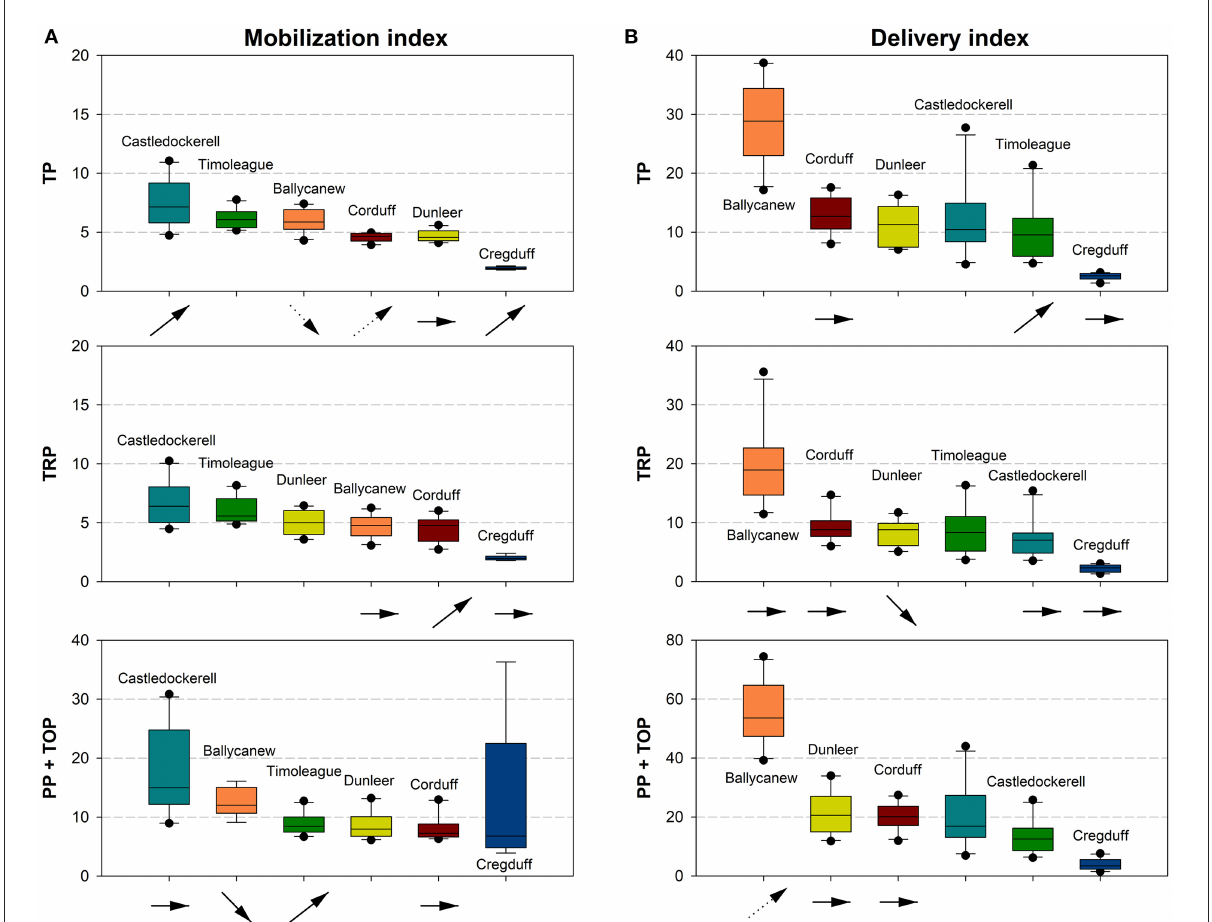
FIGURE5 (A) Mobilization indices and (B) Delivery indices of TP, TRP, and PP + TOP in six agricultural catchments. The indices are based on sub-hourly averages of P concentrations and mass loads for ten hydrological years (1st Oct 2010 to 30th Sep 2020). The arrows indicate the Mann-Kendall inter-annual trends over the period (horizontal arrow, stable; whole upward arrow, increasing; dashed upward arrow, probably increasing; whole downward arrow, decreasing; dashed downward arrow, probably